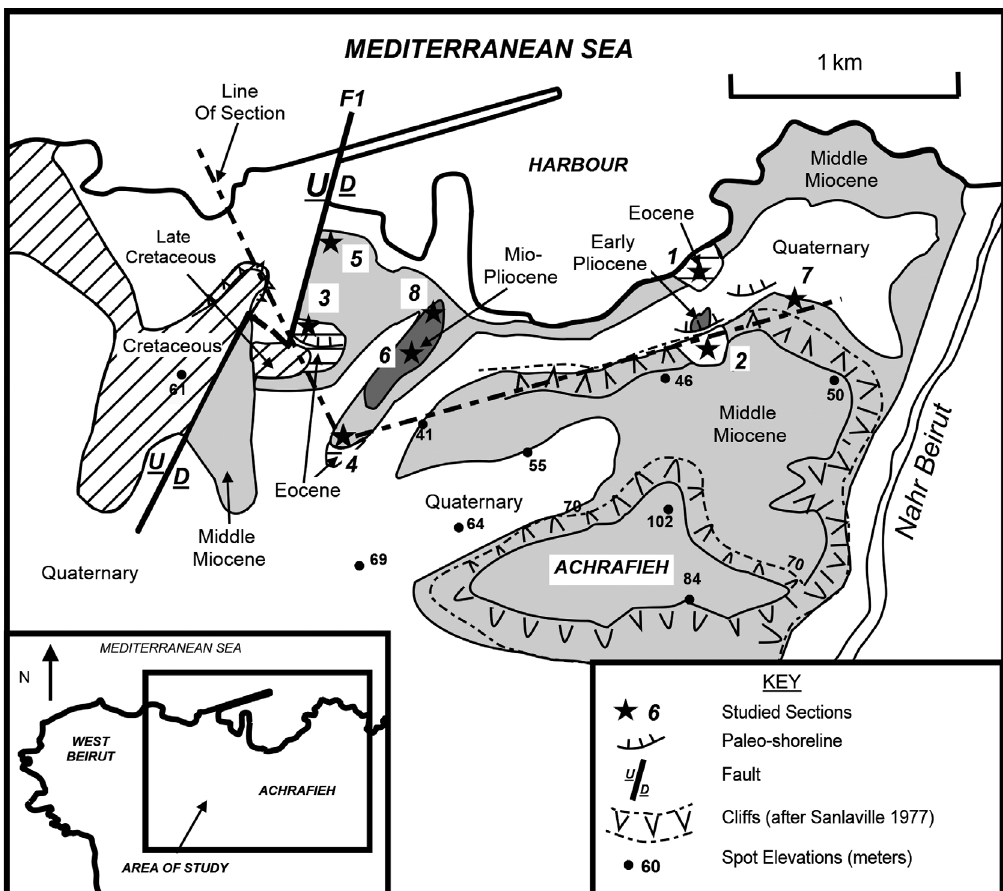
area of study and location sites based on the revised geological map of Dubertret [2], and the geomorphological map of sanlaville